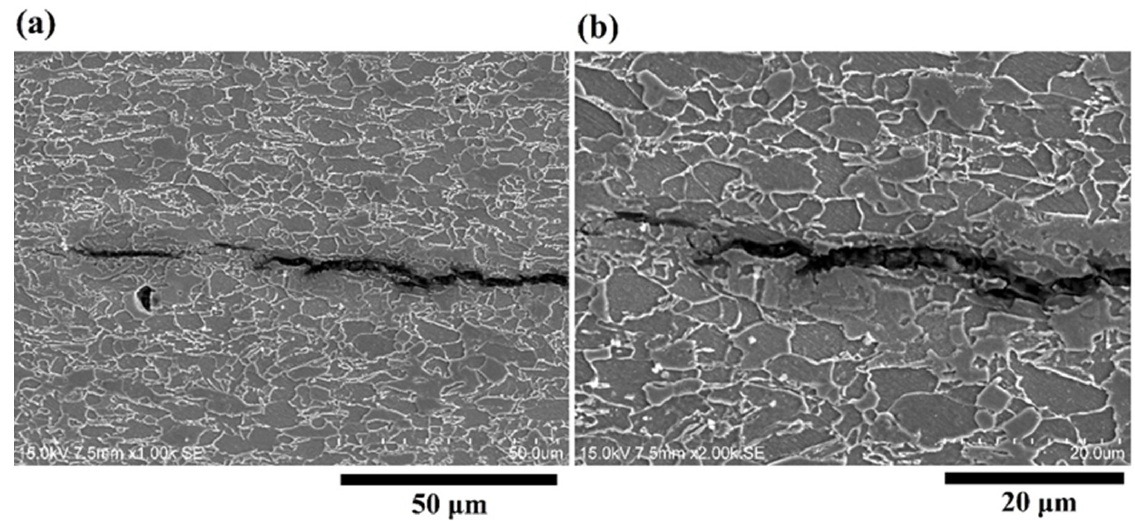
Figure 8. ( a ) SOHIC crack and ( b ) the same SOHIC crack with a higher